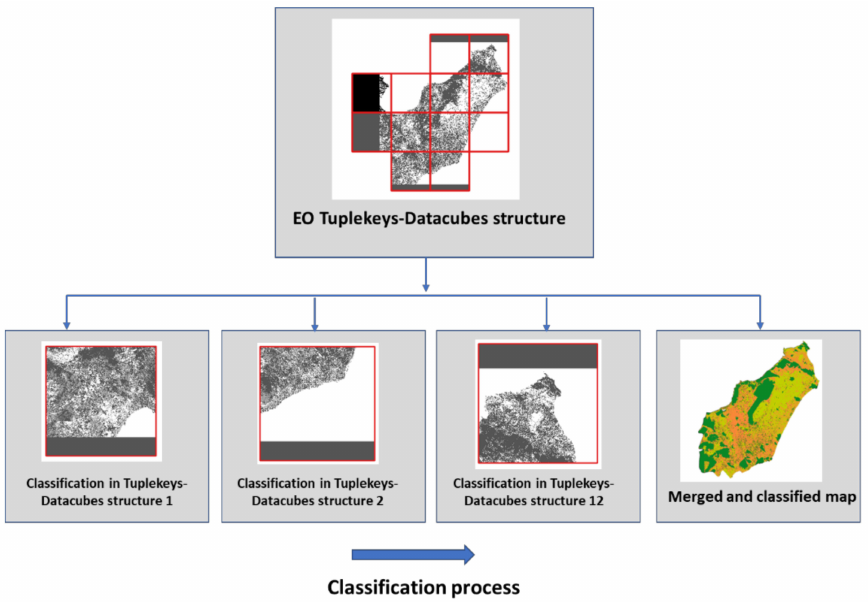
Figure 6. The classification process